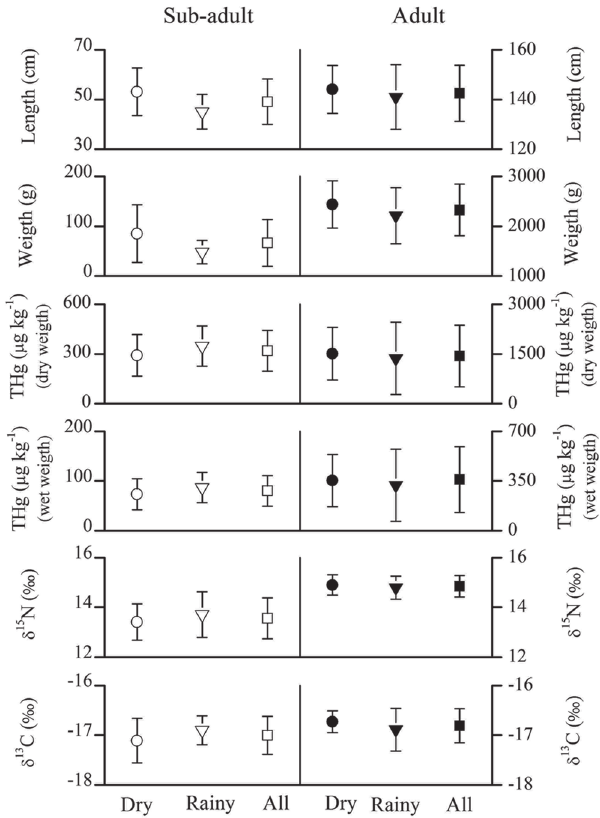
Fig. 2. Length (cm), weight (g), total mercury concentration (THg) in dry and wet weight basis and isotopic signatures ( δ 15 N and δ 13 C) of sub-adult and adult specimens of Trichiurus lepturus , considering dry season, rainy season, and all sampling periods. Data is shown as a mean and standard deviation. The scale for length, weight, and THg is different for the two ontogenetic